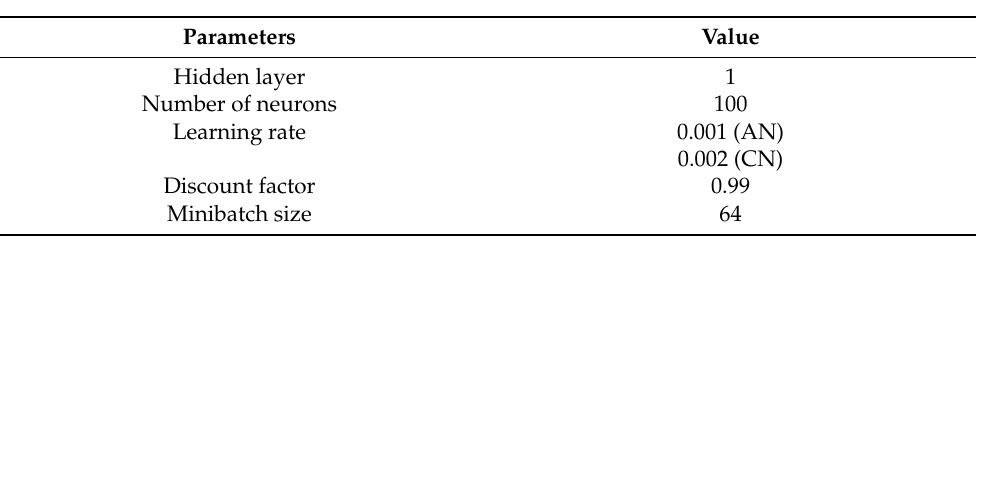
Table 2. The key parameters of PPO-based